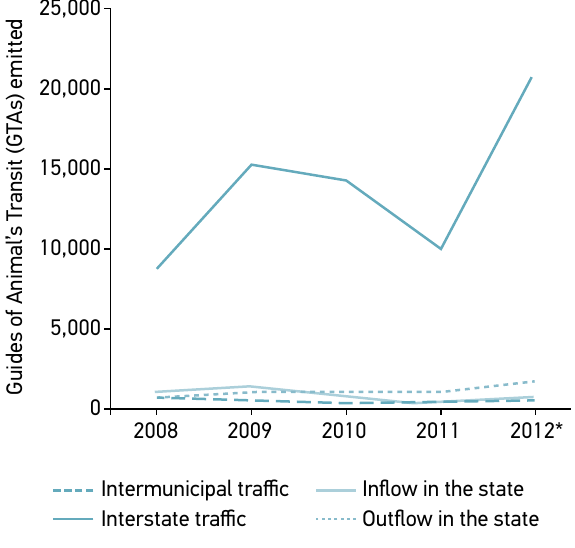
Chart 1. Number of poultry transit permits issued in the state of Sergipe, 2008–2012.